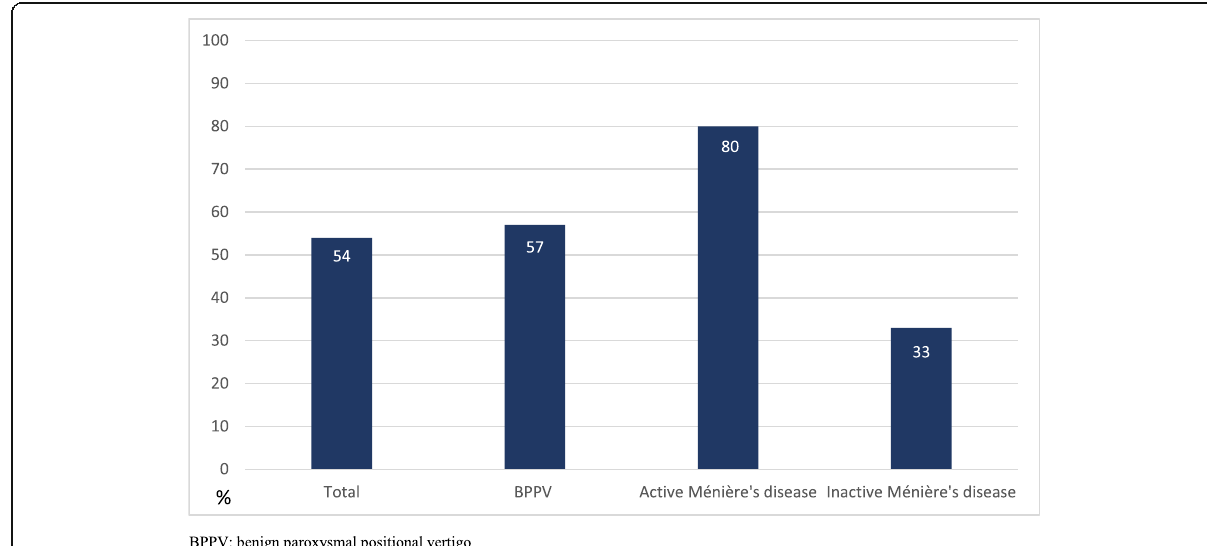
Fig. 1 Percentage of patients with abnormal values